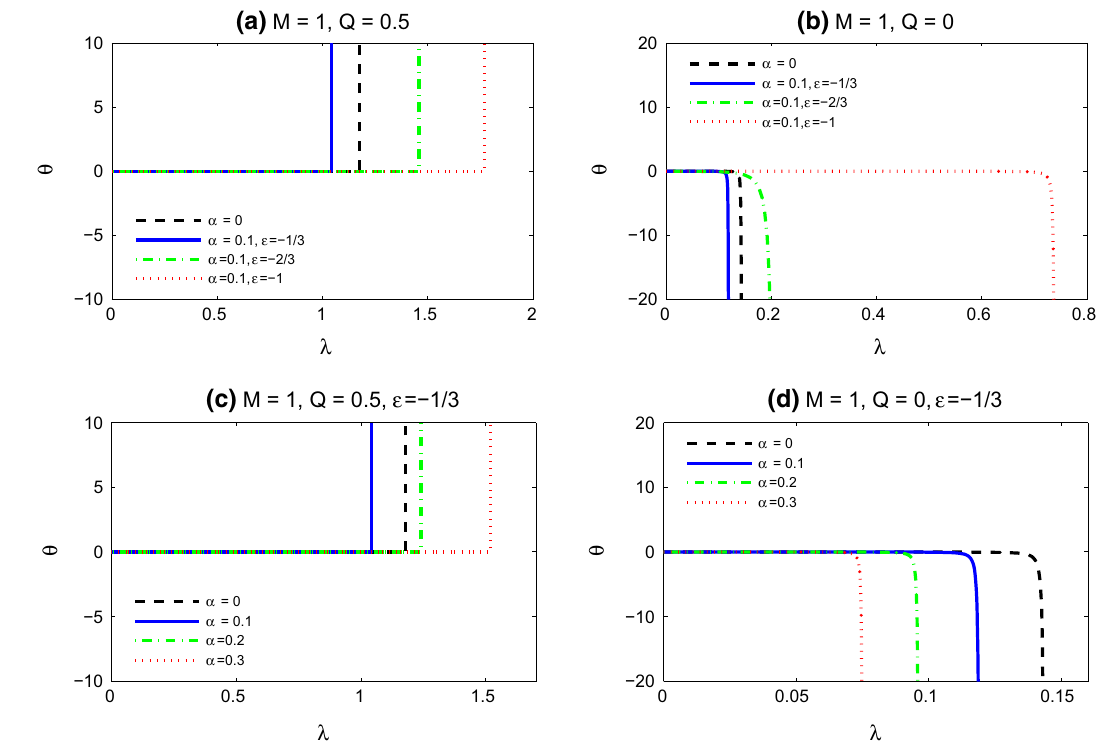
Fig. 8 The evolution of expansion scalar ( θ ) with the EOS parameter ( ε ) and the normalisation constant ( α ) without any initial shear and rotation for initially contracting congruences with θ 0 = − 0 .